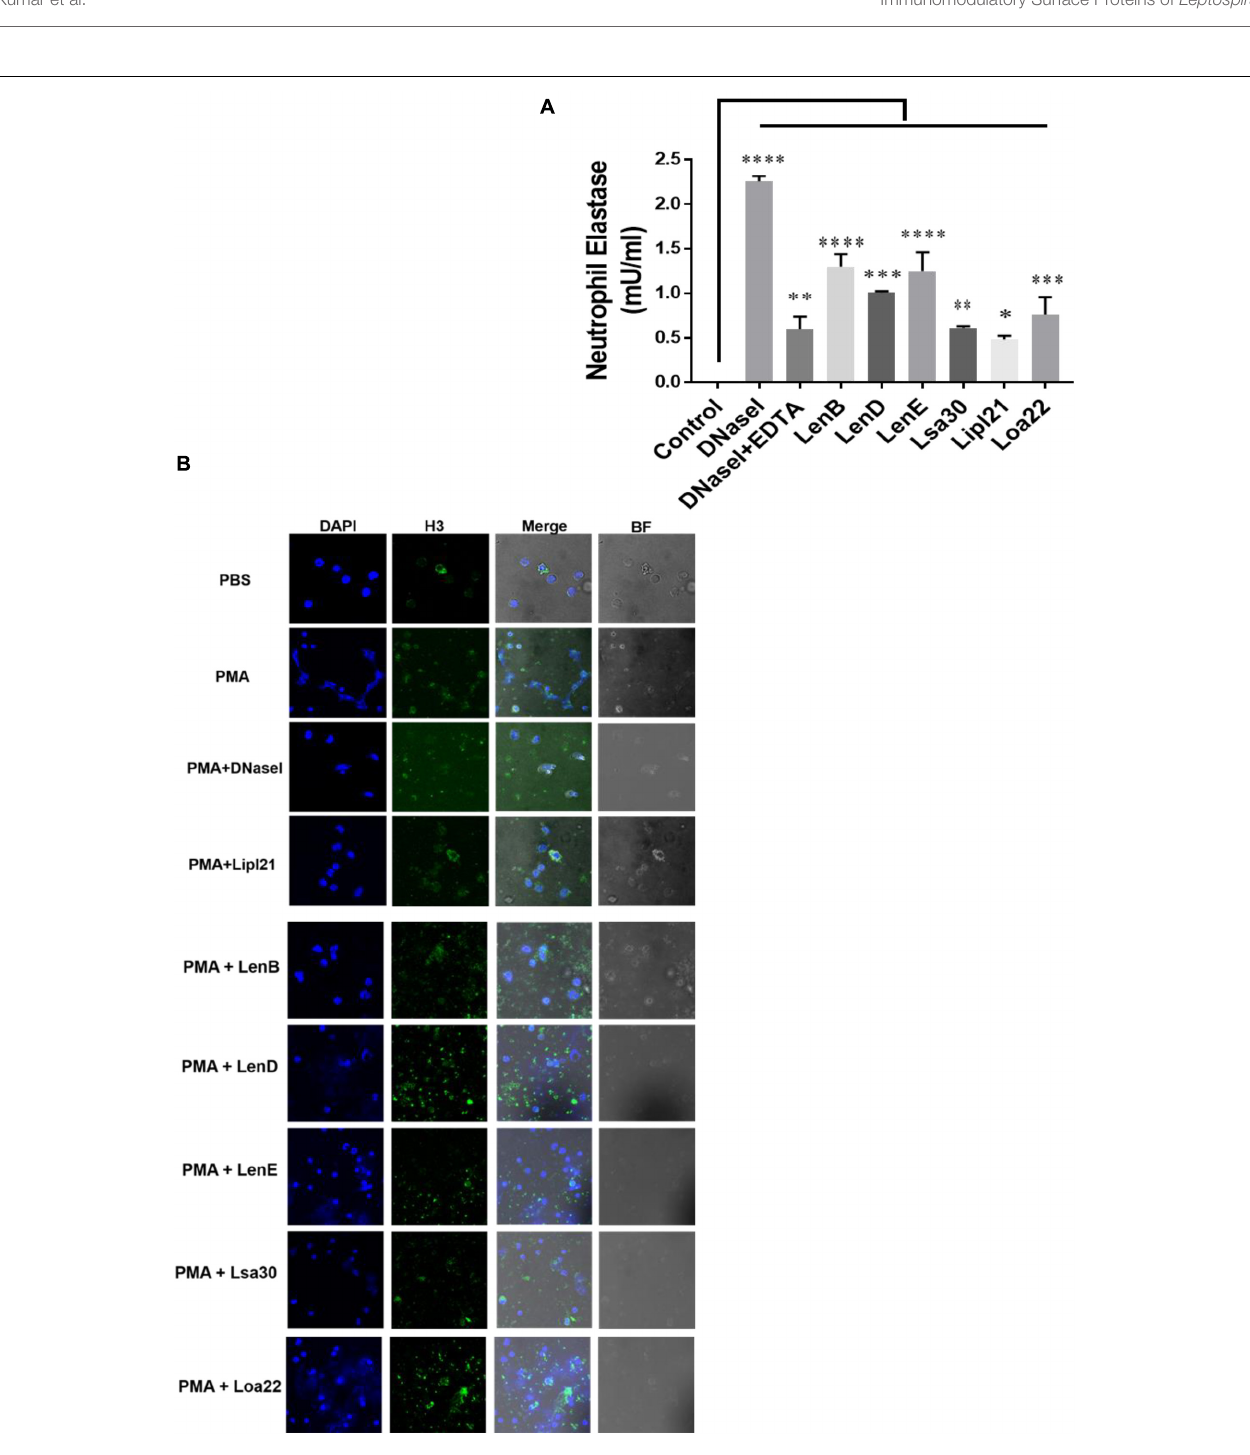
FIGURE 7 | Evaluation of surface proteins ability to degrade neutrophil extracellular trap (NET). (A) Evaluation of NETosis by elastase activity. Purified neutrophils from mouse blood were stimulated with PMA to induce NET, followed by incubation with 5 µ g of protein in nuclease assay buffer for 4 h at 37 ◦ C/5% CO 2 as described in section “Materials and Methods”. Elastase activity was determined by using a neutrophil elastase activity kit following the manufacturer’s instruction. Data are representative of three different experiments. Significant differences were calculated using the one-way ANOVA ( ∗∗∗∗ , ∗∗∗ , ∗∗ , ∗ , and ns indicates P < 0.0001, P < 0.001, P < 0.01, P < 0.05, and non-significant, respectively). (B) Evaluation of NETosis by Confocal microscopy. Neutrophils (2 × 10 5 ) were treated with PMA (50 ng/ml) and incubated for 3 h at 37 ◦ C/5% CO 2 . After washing cells were treated with 20 µ g of rLenB, rLenD, rLenE, rLsa30, rLipl21, or rLoa22 or 20 IU of DNase I in PBS containing 5 mM cocktail of MgCl 2 , CaCl 2 , and ZnCl 2 for 2 h at 37 ◦ C/5% CO 2 . Cells were washed and then stained with anti-Histone H3 antibody (1:250) overnight at 4 ◦ C, mounted with VECTASHIELD (with DAPI) and observed using a 63 × oil objective on a confocal microscope as described in section “Materials and Methods”. BF, bright